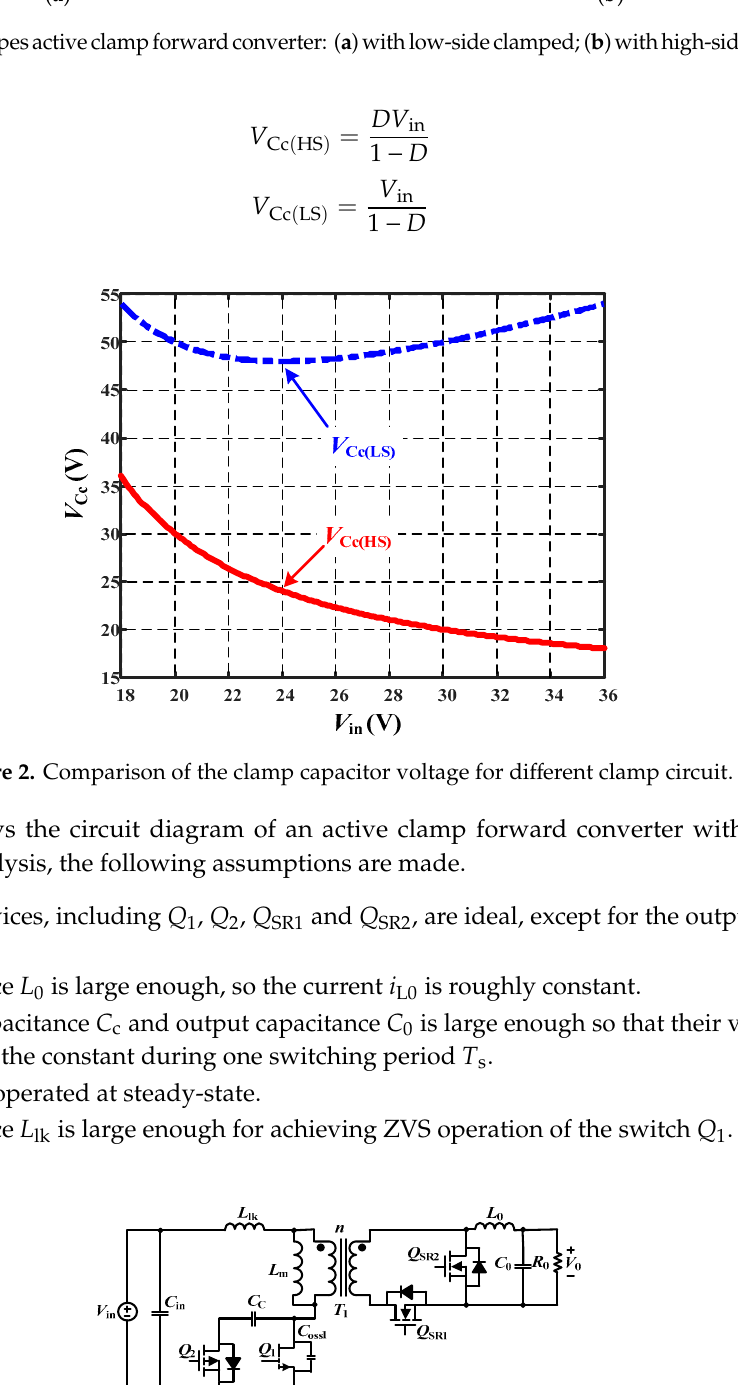
Figure 3. Schematic of GaN-based active clamp forward